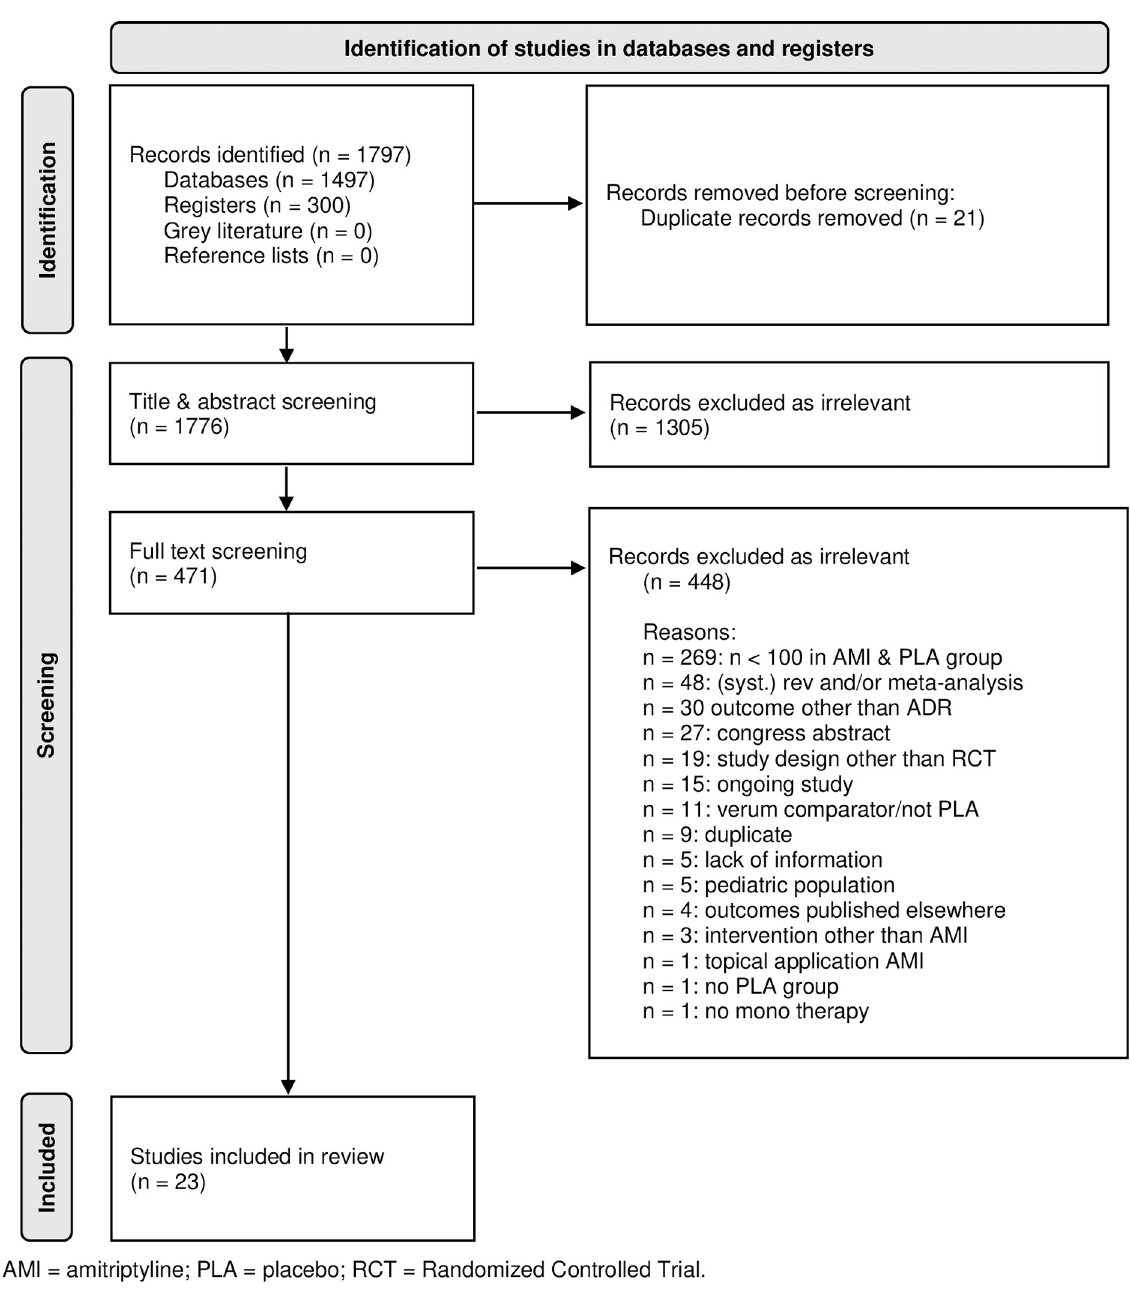
Fig 1. Flowchart of evidence selection based on PRISMA. AMI = amitriptyline; PLA = placebo; RCT = Randomized Controlled Trial.